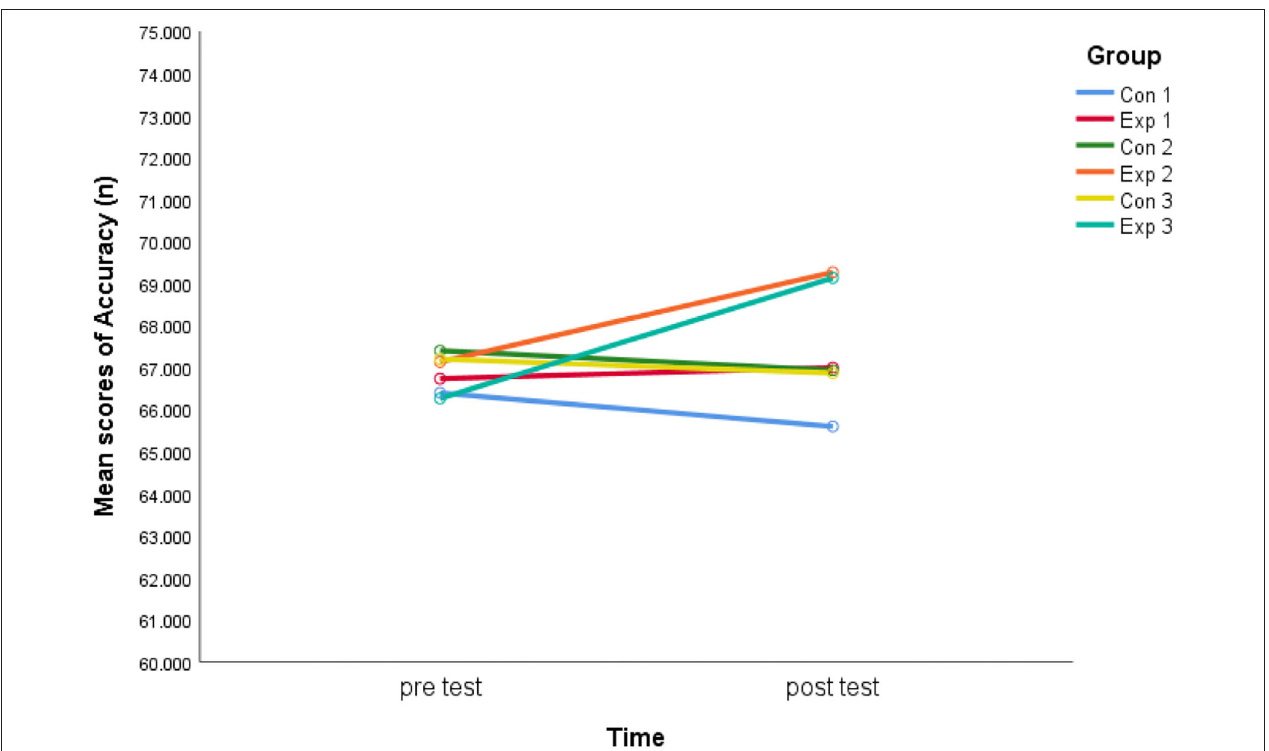
FIGURE 4 | Interaction effect for accuracy.